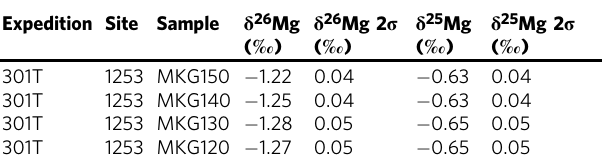
Table 4 Mg isotope values of IODP Site 1253 basaltic basement fl